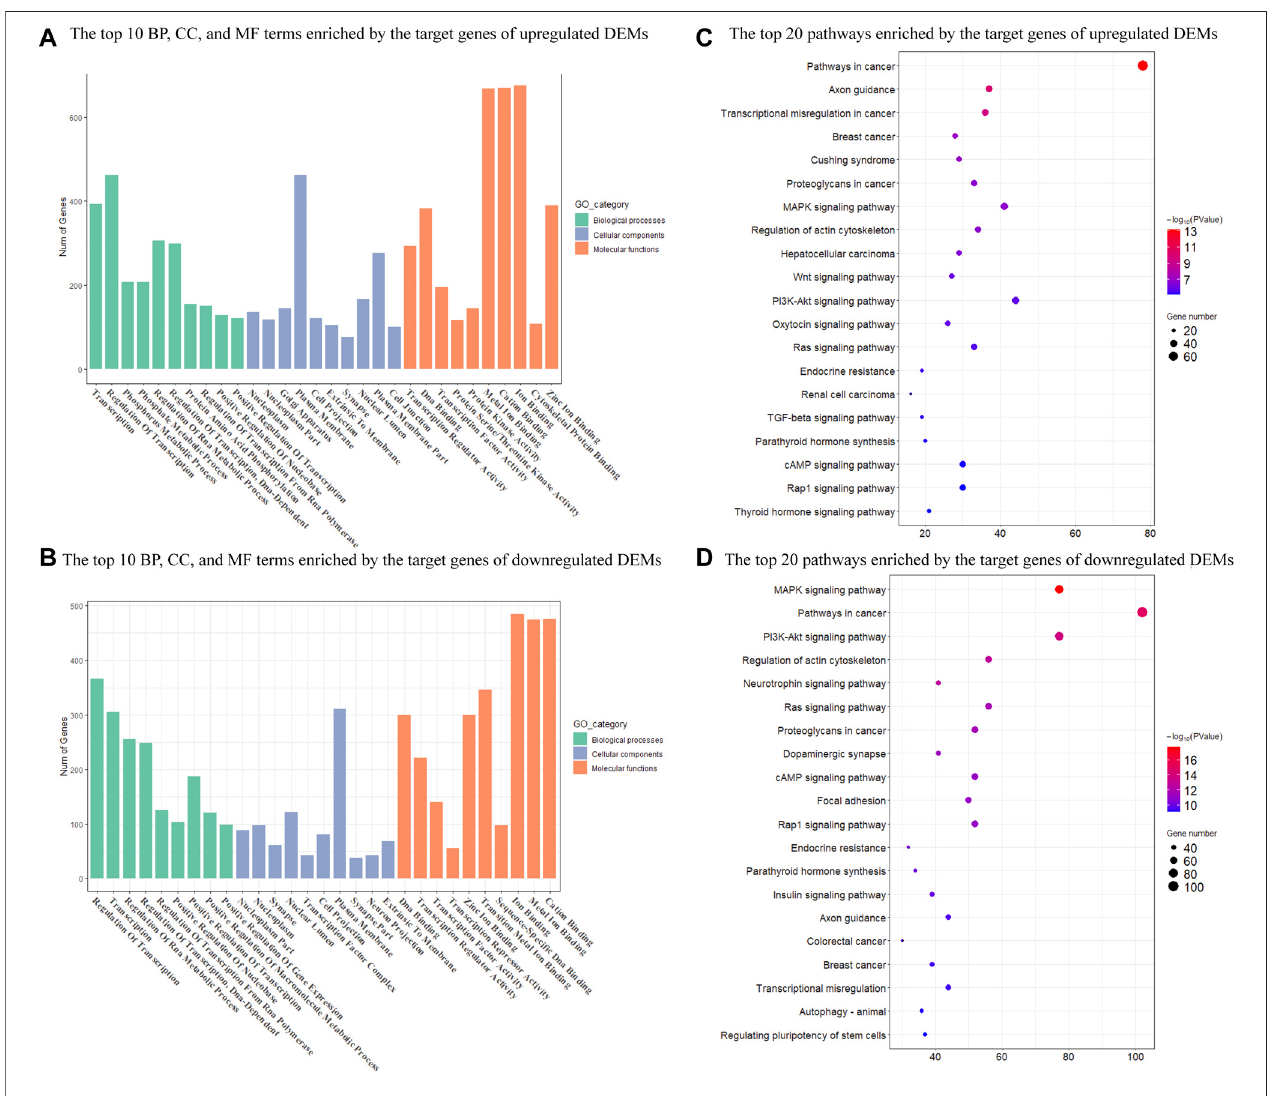
FIGURE 3 | Enrichment analysis of target genes of DEMs in Md fi -OE vs. WT. (A) . The fi rst 10 biological processes (BP), 10 cellular component (CC), and 10 molecular function (MF) are enriched by the target genes of upregulated DEMs. (B) . The top ten biological processes (BP), cellular component (CC), and molecular function (MF) are enriched by the target genes of downregulated DEMs. (C) . The fi rst twenty pathways of the target genes of upregulated DEMs. (D) . The fi rst twenty pathways of the target genes of downregulated